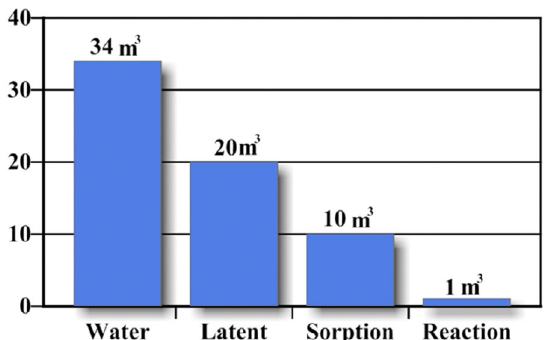
Fig. 1 Volume required to store 1850 kWh (With consideration of 25% heat losses, based on a 70 ℃ temperature increase for water) [23,